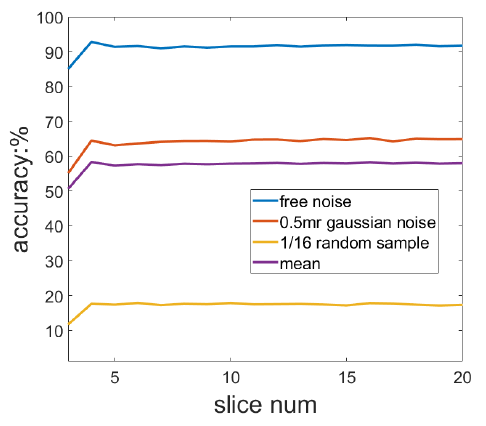
Figure 5. The relationship between the number of slices and the LRF accuracy.